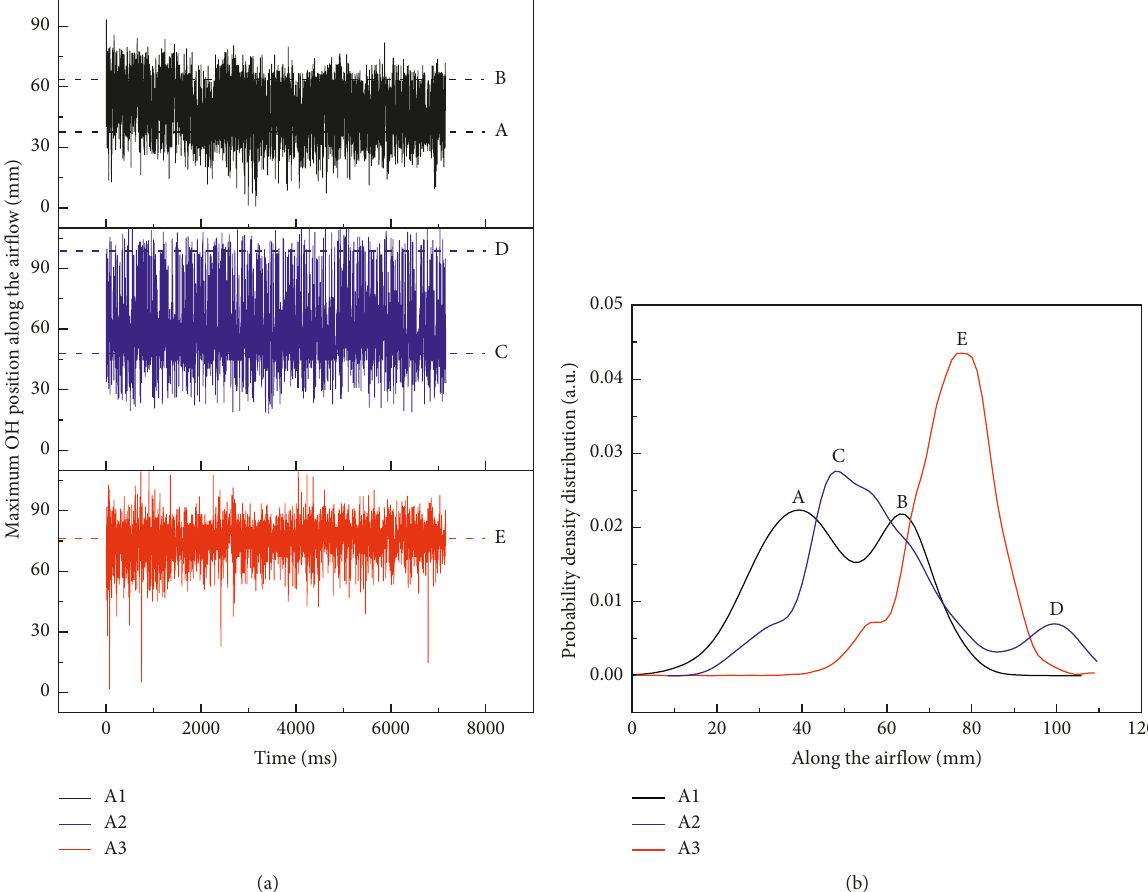
Figure 4: (a) Oscillation curves of the strongest burning position under three oxy-fuel conditions. The dash indicates the peak position of probability density distribution. (b) Probability density distribution of the oscillation data. A–E express the oscillation peaks.